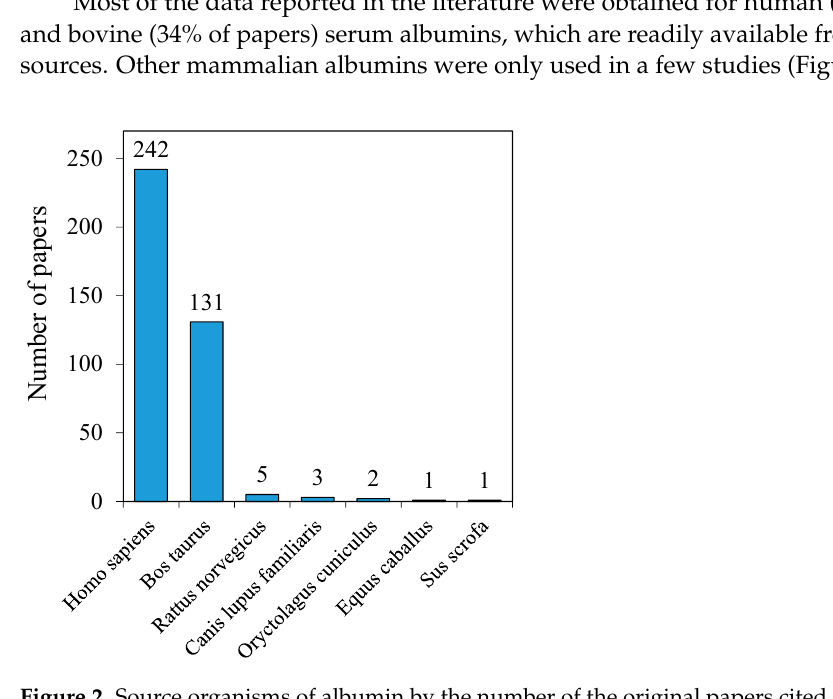
Figure 1. Experimental techniques used for the measurement of albumin-binding constants by num- ber of the original papers cited in the dataset in which these techniques were applied.